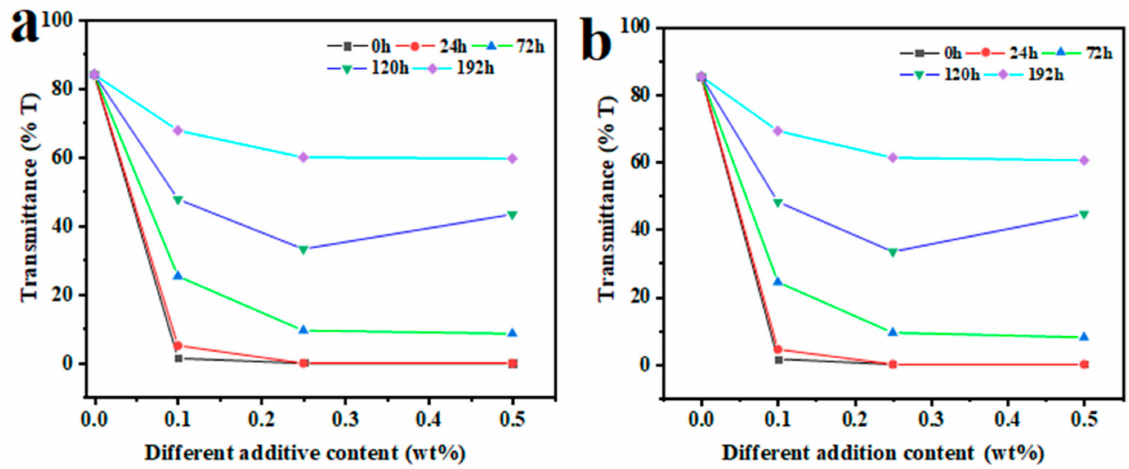
Figure 11. Graph of the relationship between different addition contents and transmittance with wavelengths of ( a ) 400 nm and ( b ) 630